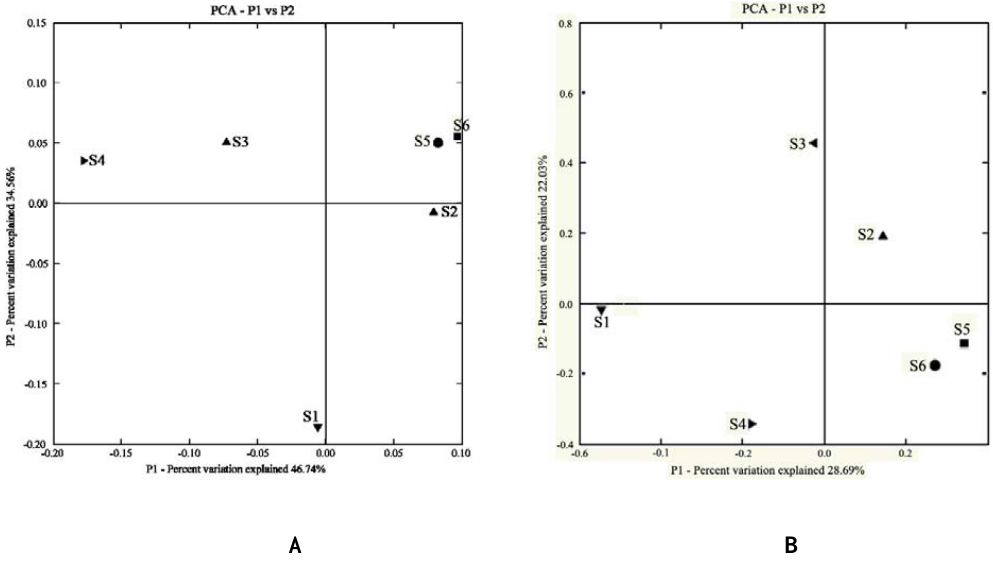
Fig. 6. PCoA ordination diagrams of the bacterial (A) and archaeal (B) assemblages calculated with 16S rRNA gene sequences from production water of petroleum reservoirs. Shown are the plots of the first two principal coordinate axes (P1 and P2) for PCoA and the distributions of the bacterial and archaeal assemblages (designated with the sampling wells) in response to these axes.